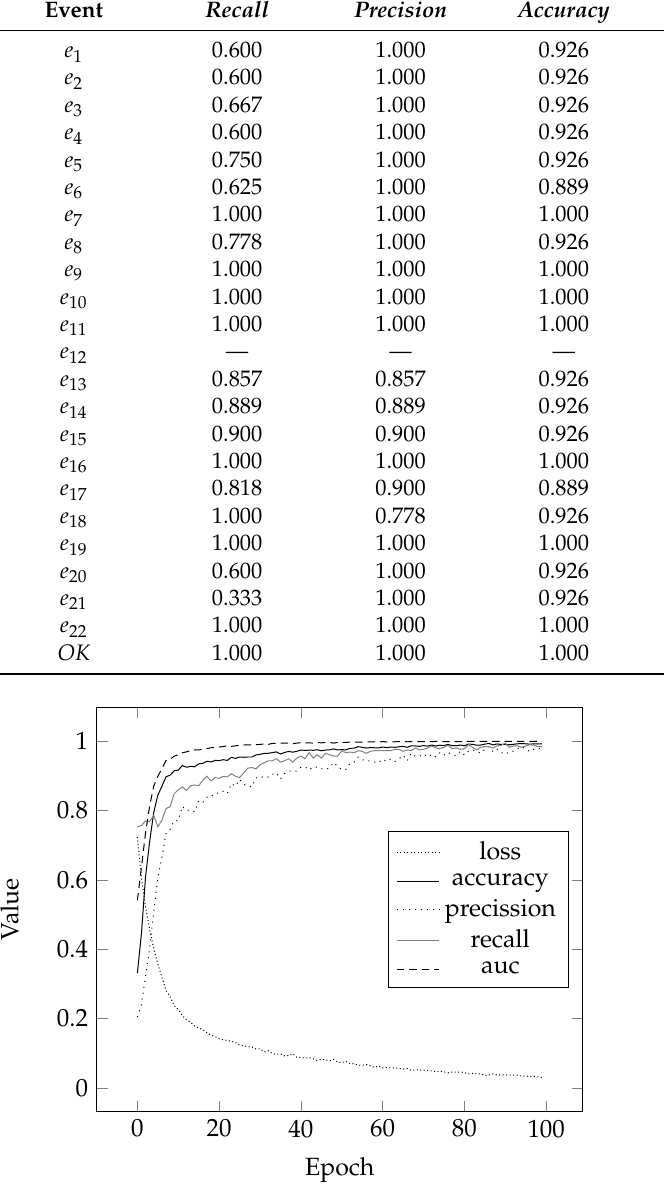
Figure 7. The history of ANN learning